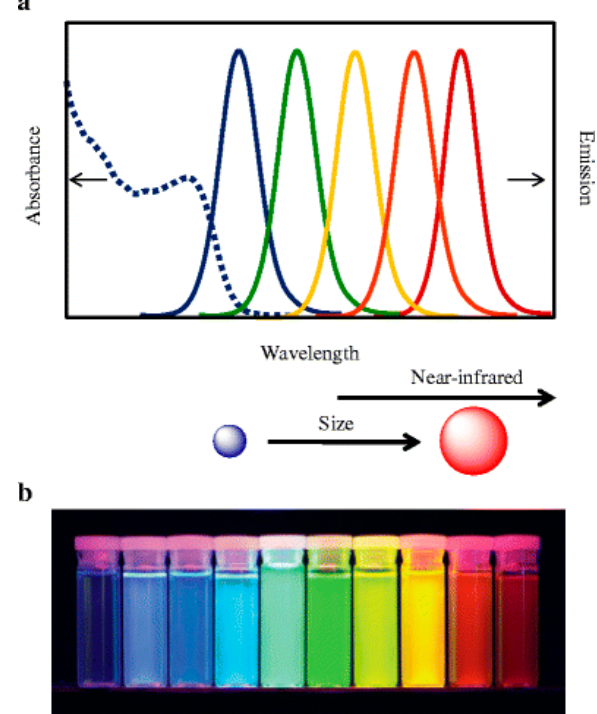
Figure 1. ( a ) Size-tunable emission spectra of QDs; ( b ) 10 distinguishable emission colors of ZnS- capped CdSe QDs by a near-UV lamp. From left to right (blue to red), the emission maxima are located at 443, 473, 481, 500, 518, 543, 565, 587, 610, and 655 nm